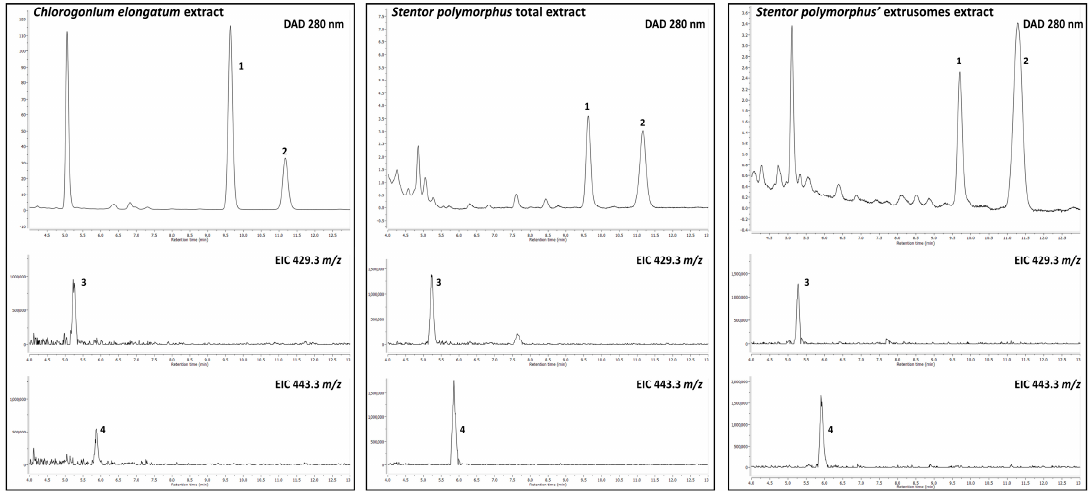
Figure 8. LC-UV-MS chromatograms of Chlorogonium (left panel), S. polymorphus cells (central panel) and the S. polymorphus extrusomes discharge (right panel) extracts. UV chromatograms are displayed for ergosterol 1 and 7-dehydroporiferasterol 2 (280 nm), while EIC traces are displayed for the oxidized analogues 3 and 4 (429.3 and 443.3 m / z ,